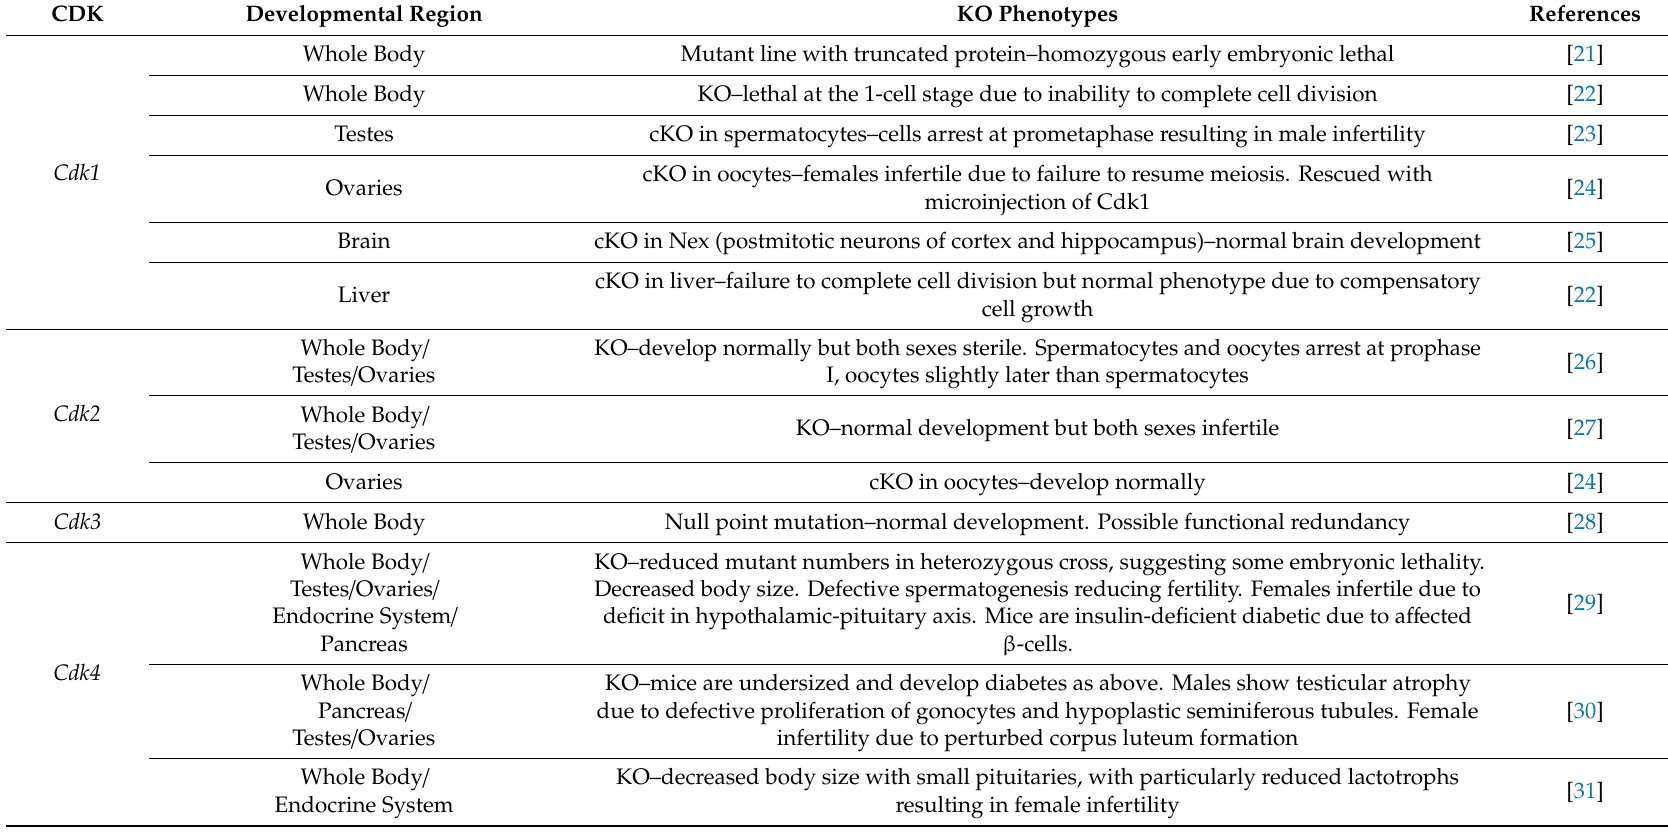
Table 1. Phenotypes of CDK (cyclin-dependent kinase) KO (knock-out) and cKO (conditional KO) in